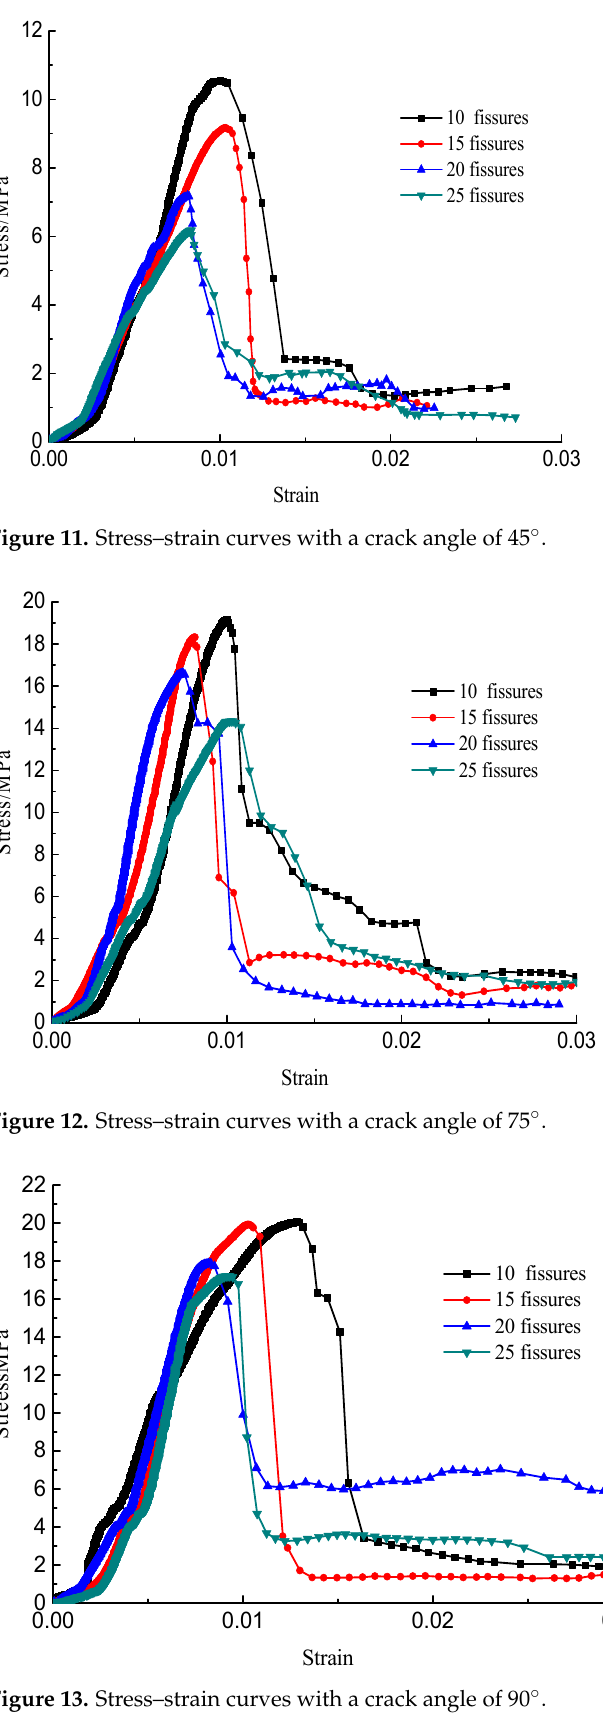
Figure 10. Stress–strain curves with a crack angle of 25°.